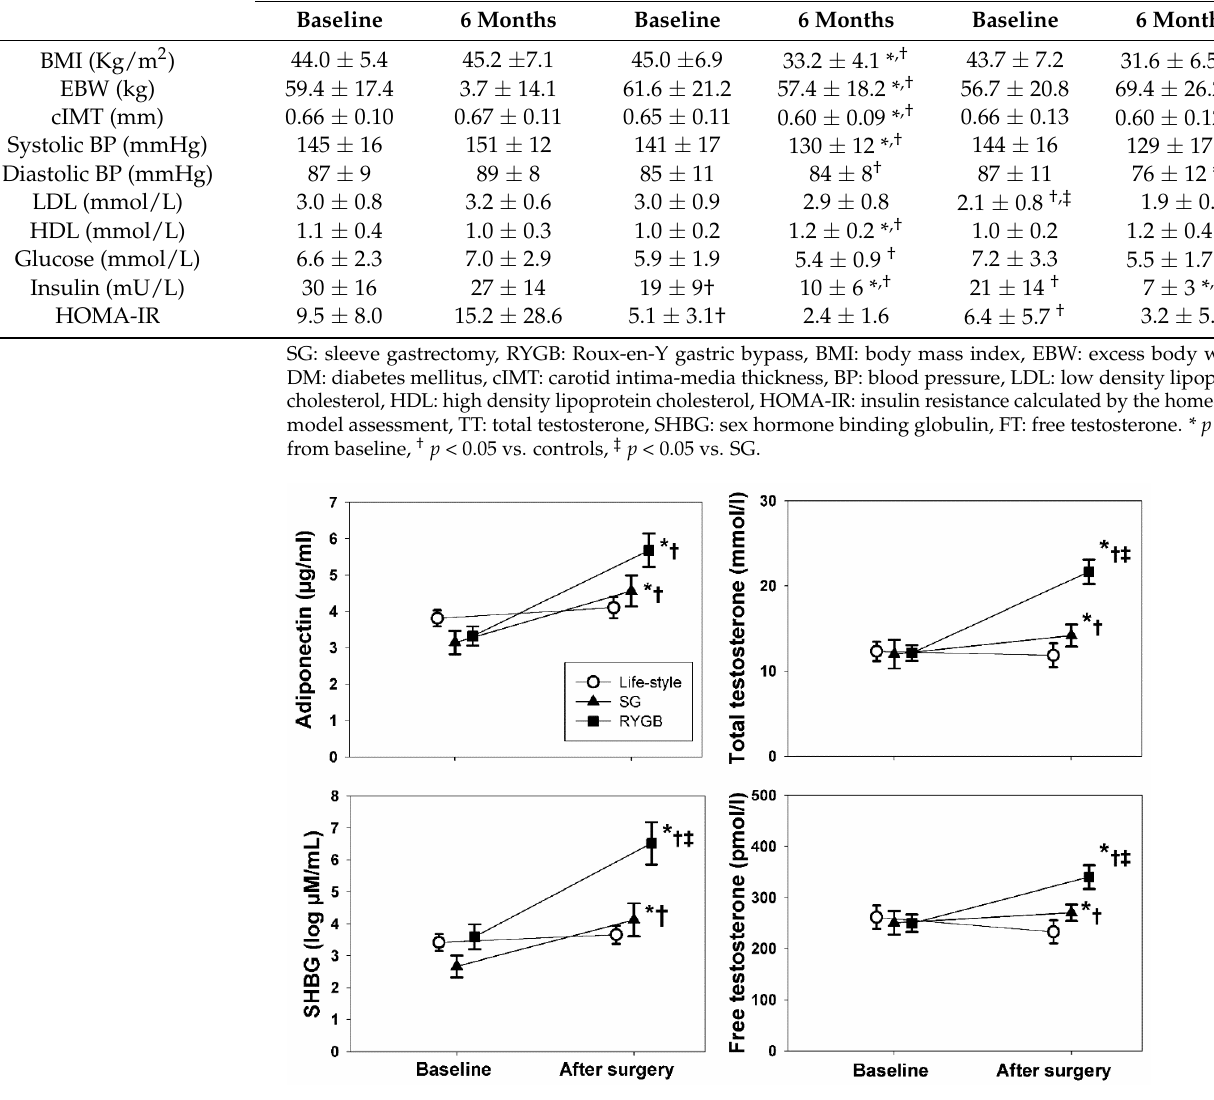
Figure 2. Changes in circulating adiponectin and androgens in the included men after obesity surgery. Symbols represent means and error bars represent SEMs. * p < 0.05 from baseline, † p < 0.05 vs. lifestyle modification, ‡ p < 0.05 vs. SG.